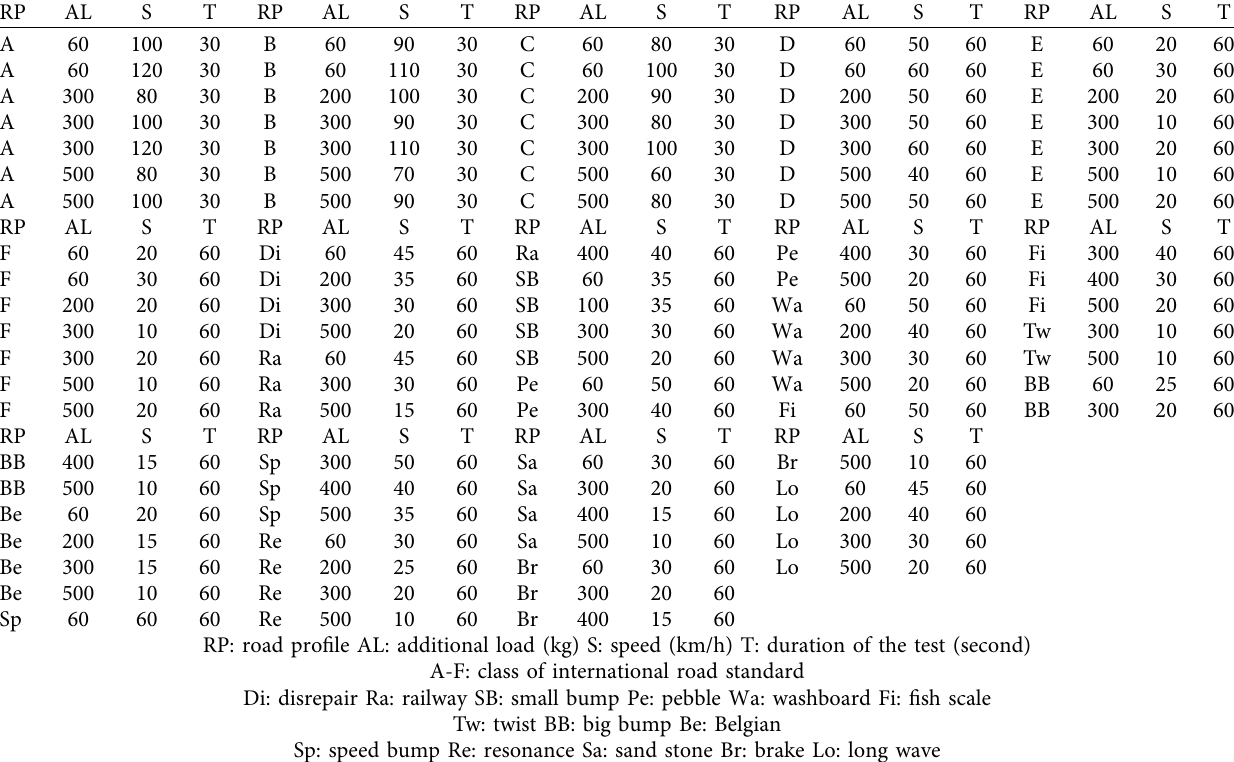
Table 2: All the driving cycles in the bench